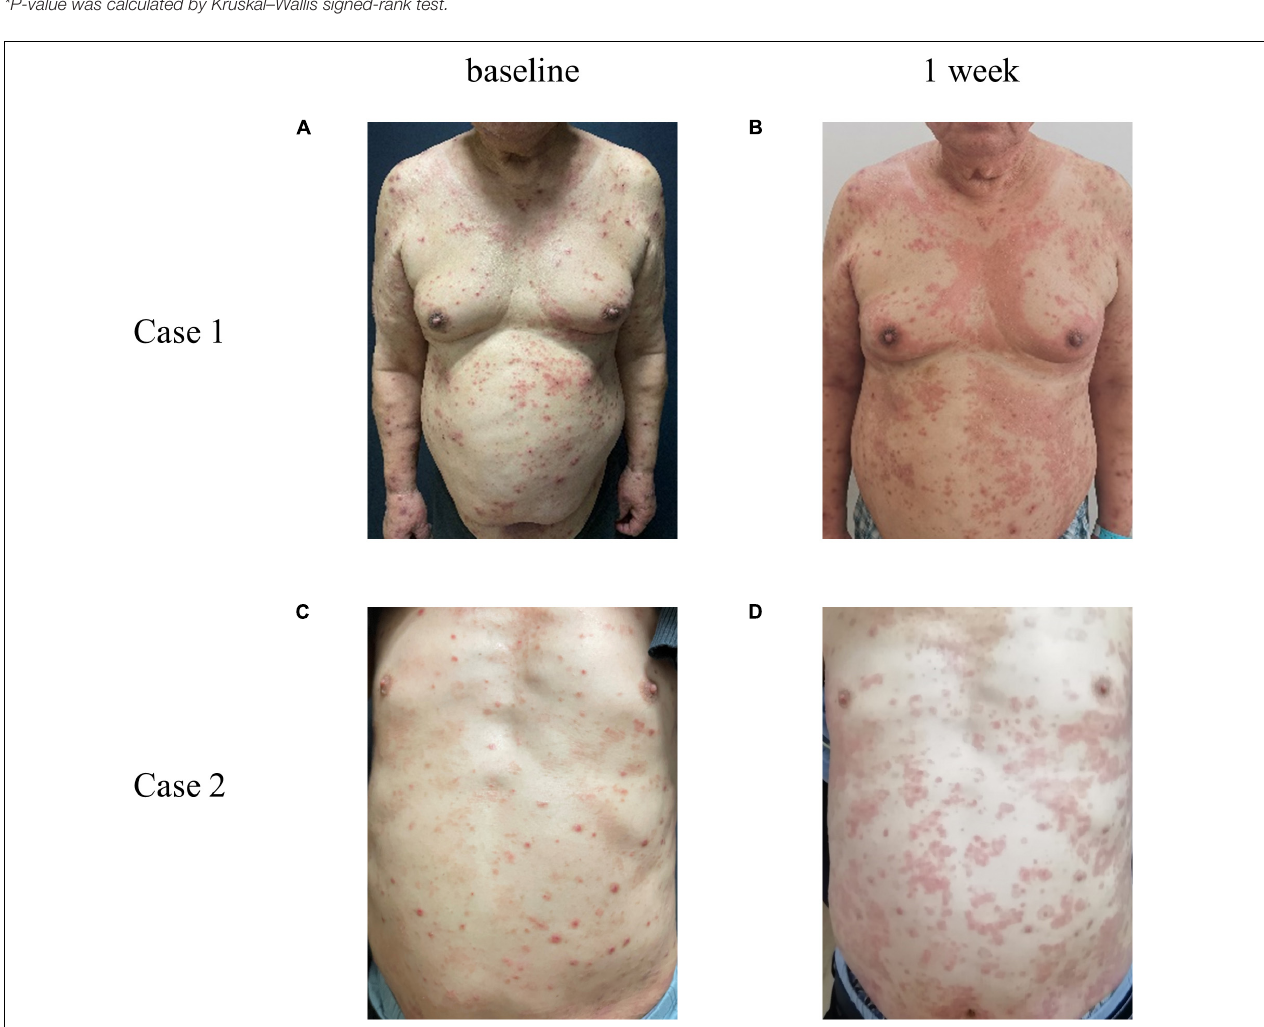
FIGURE 2 | Representative photos of AD patients with allergic reaction after subcutaneous injection of dupilumab. Case 1 and 2 represent two different patients. Compared with the condition at baseline (A,C) , 1 week (B,D) after the first subcutaneous injection of dupilumab, a large number of edematous erythema and papules suddenly appeared all over the body, fused into a piece, with fine scales on the surface, accompanied by severe itching.